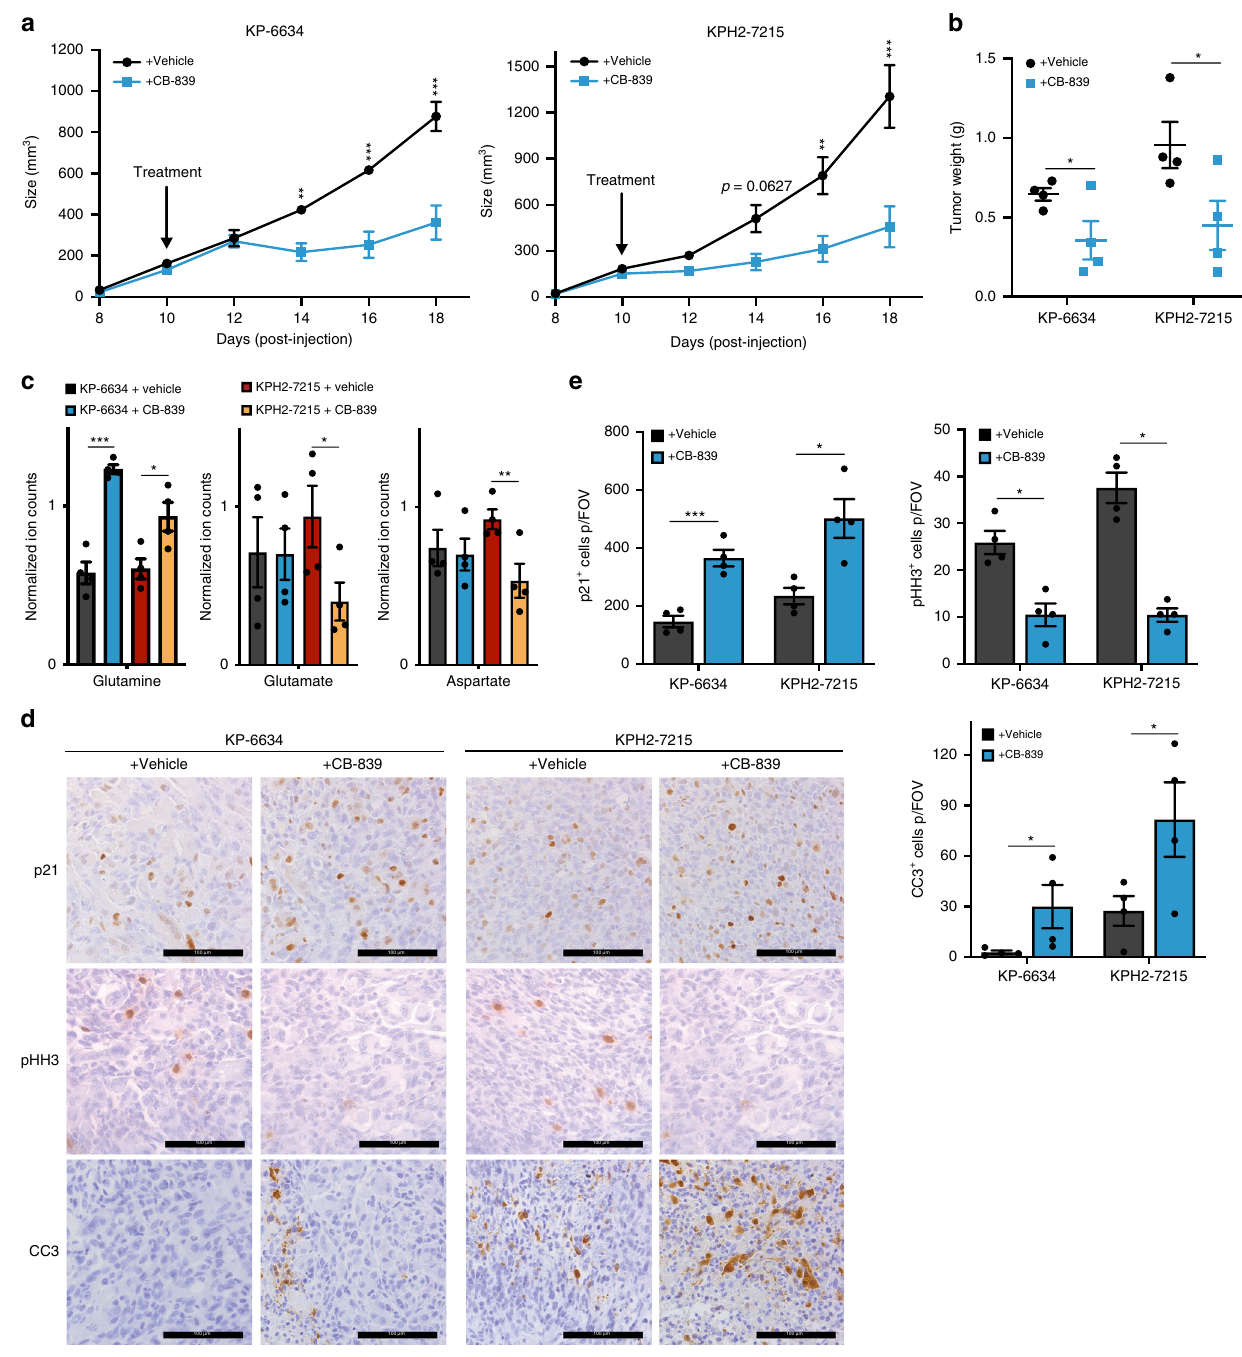
Fig. 6 Glutaminase inhibition effectively blunts UPS allograft growth. a Tumour size of subcutaneous KP-6634 (left), KPH2-7215 (right) allografts in vehicle ( n = 4) or CB-839-treated mice ( n = 4). Mice were treated once tumours reached ∼ 100 mm 3 at ~10 days post-injection. Data represent mean ± s.d.; ** p < 0.005, *** p < 0.0005. b Tumour weights from vehicle- and CB-839-treated KP-6634 and KPH2-7215 allograft mice ( n = 4). Error bars are s.d.; * p < 0.05. c Normalized ion counts for glutamine, glutamate, and aspartate (left to right) in KP-6634 and KPH2-7215 allograft tumours from vehicle- and CB-839-treated animals. N = 4 with two technical replicates. Data represent mean ± s.d.; * p < 0.05, ** p < 0.005, *** p < 0.0005. d Representative immunohistochemistry staining for p21 (top row), phospho-histone H3 (middle row; pHH3), and cleaved-caspase 3 (bottom row; CC3) in KP-6634 and KPH2-7215 allografts of vehicle- ( n = 4) and CB-839-treated ( n = 4) animals. Scale bars = 100 μ m. e Quanti fi cation of p21 + (top left), pHH3 + (top right), and CC3 + (bottom right) cells per fi eld of vision (FOV) in vehicle- and CB-839-treated animals. N = 4 with fi ve images taken per section. Data represent mean ± s.e.m.; * p < 0.05, *** p < 0.0005. p -Values were calculated from a two-tailed Student ’ s t -test for a – c , e . Source data are provided as a Source Data fi